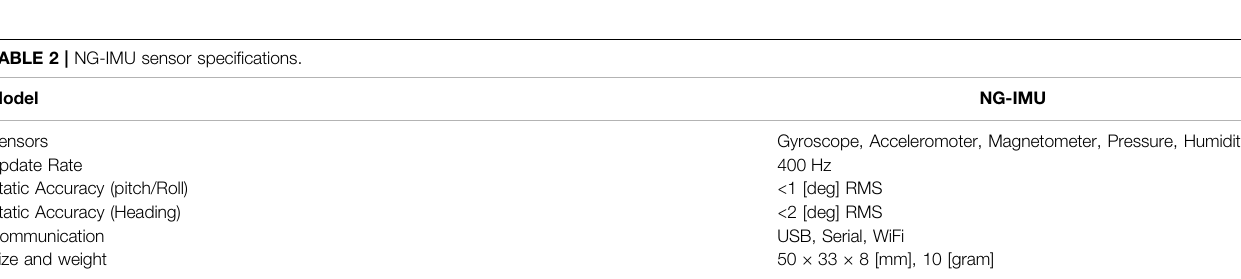
TABLE 2 | NG-IMU sensor speci fi cations.